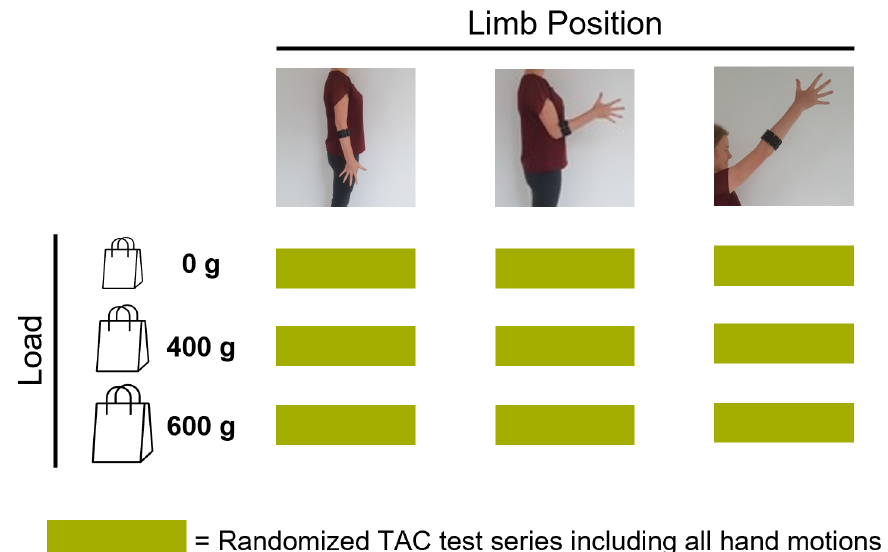
Figure 11. Familiarization phase procedure. The subject was familiarized with TAC test in for all variation of external factors. A TAC test series was conducted for each combination of limb position and external load.